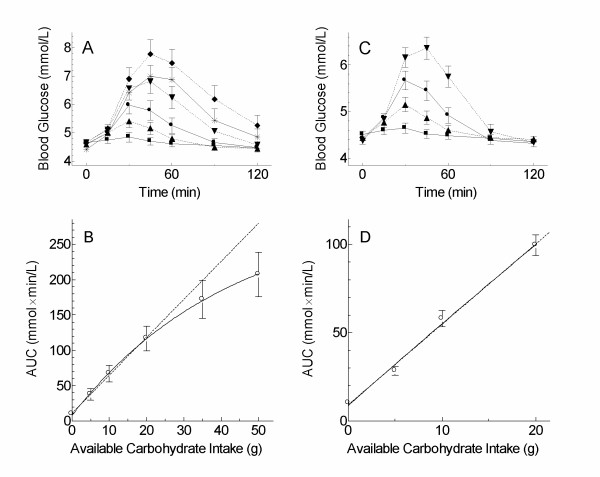
Blood glucose responses elicited by different doses of white bread. A: blood glucose concentrations in n = 10 subjects after 0 (■), 5 (▲), 10 (●), 20 (▼), 35 () and 50 g (◆) carbohydrate; B: incremental areas under the curve (AUC) for data in panel A, solid line is non-linear regression through all points (AUC = 291 × (1-e-0.0233 g) + 7.84), dashed line is linear regression through 0, 5, 10 and 20 g points (AUC = 5.38 g + 10.9); C: blood glucose concentrations in n = 48 subjects after 0, 5, 10 and 20 g carbohydrate; D: AUC values for data in panel C, solid line is non-linear regression (1530 × (1-e-0.00306 g) + 8.79), dashed line is linear regression (AUC = 4.55 g + 9.14). Points are means ± SEM.